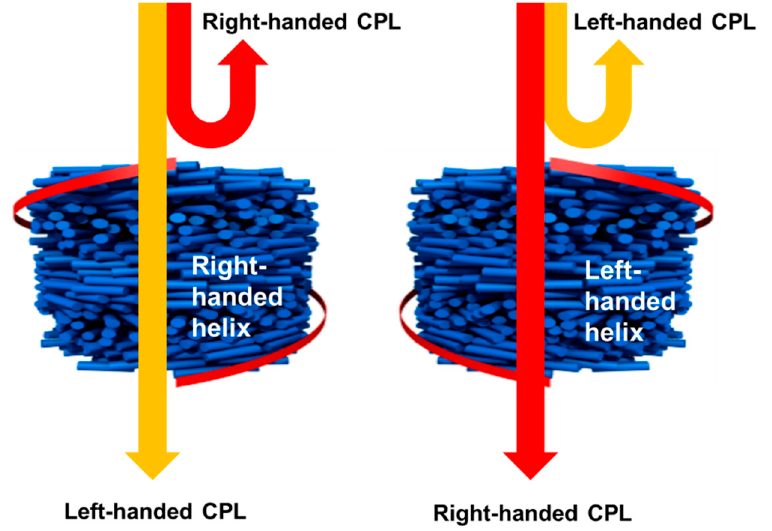
Figure 1. Illustration of the reflective and transmissive optical characteristics of Ch phases. First, three colored Ch mixtures were fabricated by doping a chiral dopant (Iso- (6OBA) 2 [17], synthesized in our laboratory) in a calamitic nematic liquid crystal (NLC) mixture (HTW109100-100, HCCH). The host NLC showed the following phase sequence during the heating process: Crystal ( − 40 ◦ C) nematic (112 ◦ ) isotropic liquid. Red (R), green (G), and blue (B) colored Ch mixtures were obtained by blending the NLC mixture with 4.9, 5.5, and 6.4 wt% chiral dopants, respectively. All the prepared Ch mixtures exhibited